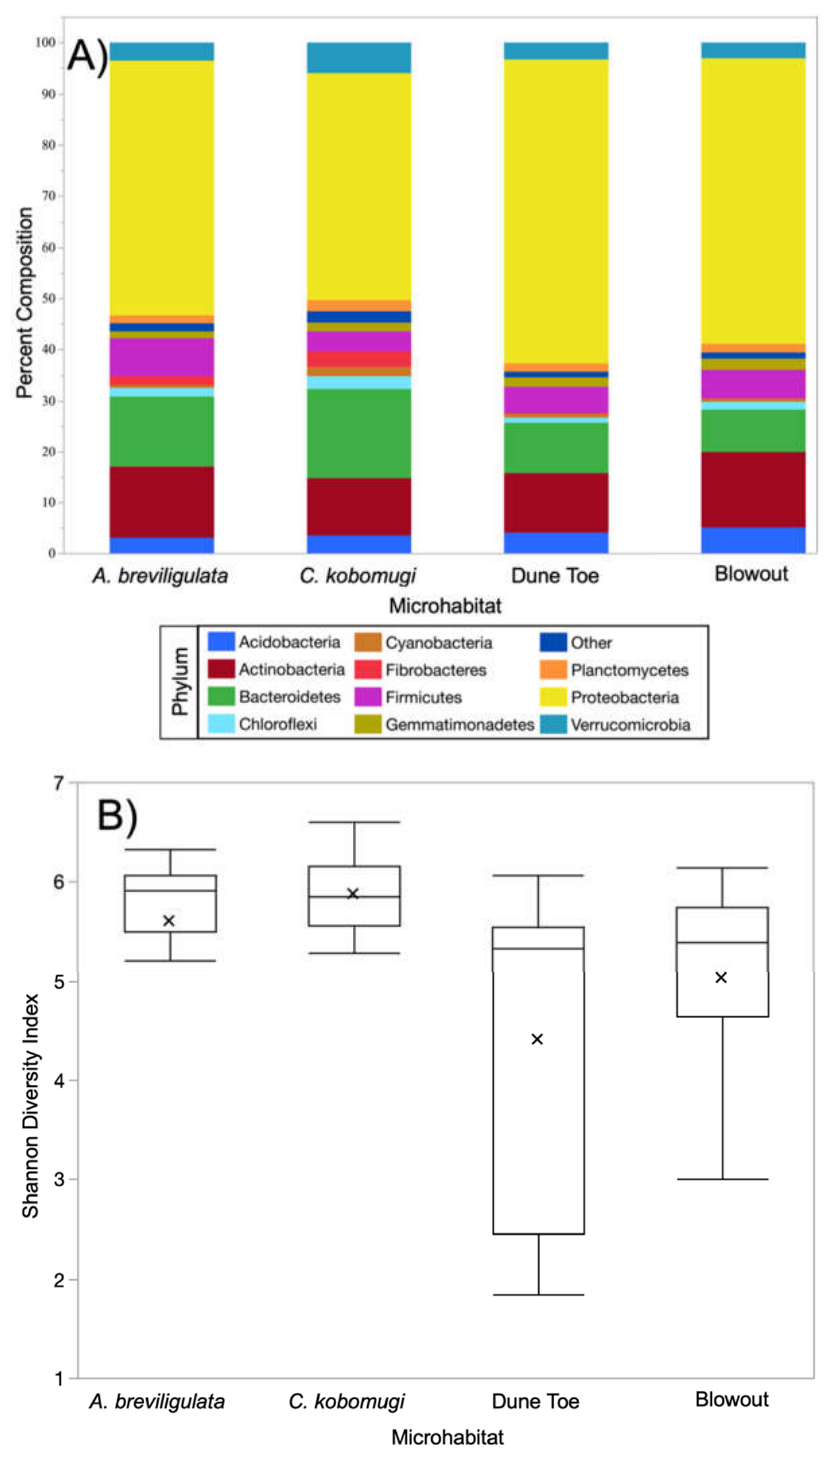
Figure 1. Phylum composition and diversity across microhabitats. ( A ) Phylum composition across microhabitats varied, ( B ) as did Shannon diversity, whereby the two vegetated habitats are more similar to each other than to either barren microhabitat.